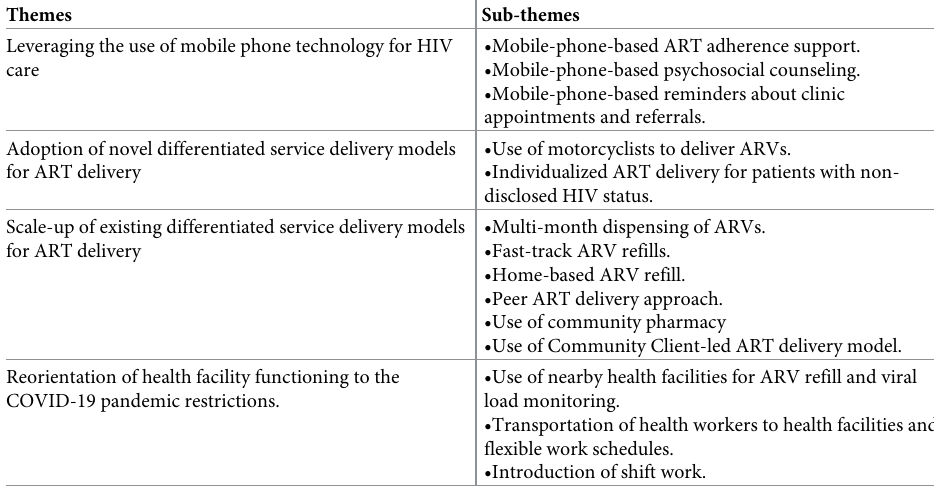
Table 2. Summary of emergent